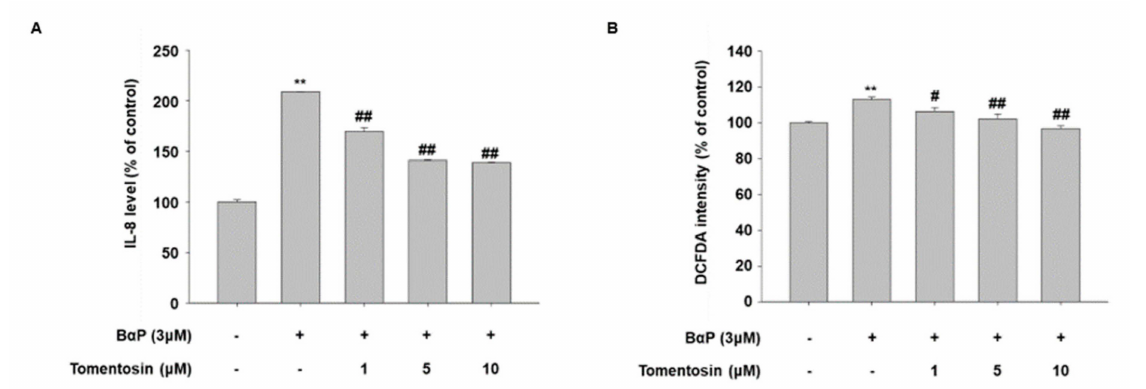
Figure 6. Tomentosin reduces the production of intracellular interleukin (IL)-8 and reactive oxygen species (ROS) induced by benzo[a]pyrene (B[a]P). ( A , B ) HaCaT cells were treated with 1, 5, or 10 µ